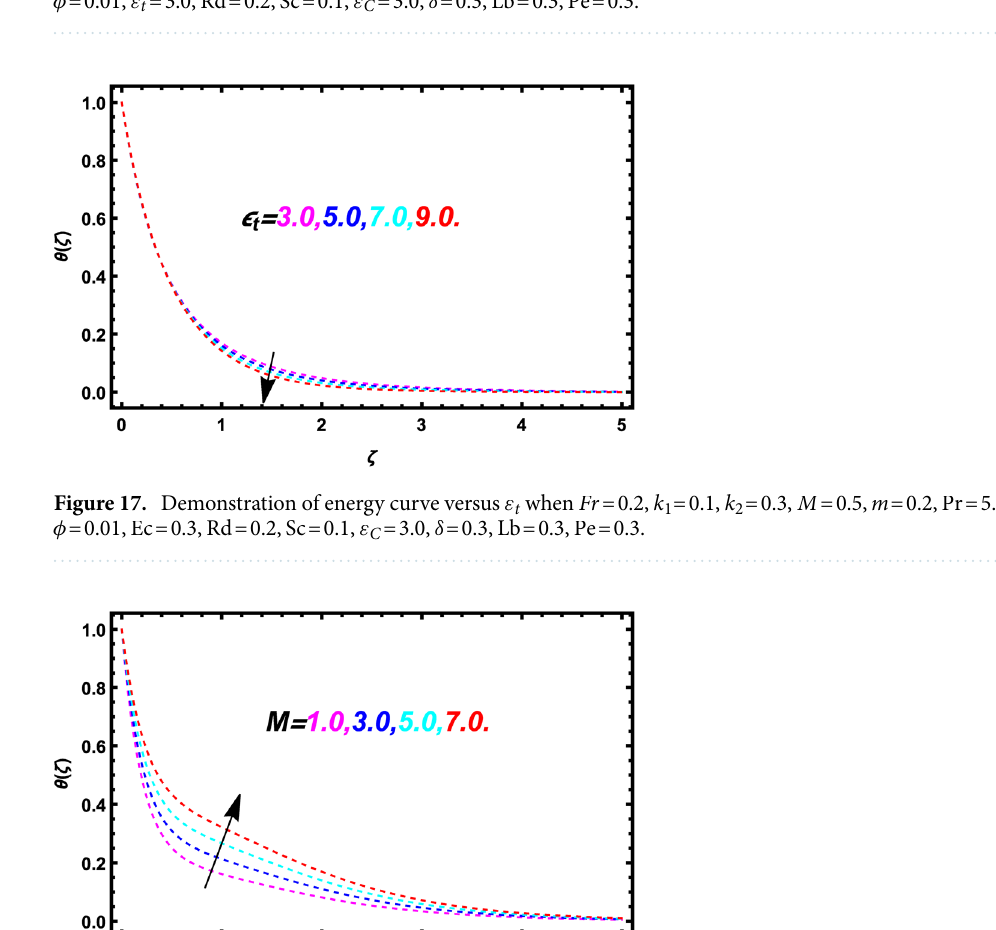
Figure 16. Demonstration of energy curve versus Ec when Fr = 0.2, k 1 = 0.1, k 2 = 0.3, M = 0.5, m = 0.2, Pr = 5.3, φ = 0.01, ε t = 3.0, Rd = 0.2, Sc = 0.1, ε C = 3.0, δ = 0.3, Lb = 0.3, Pe = 0.3.